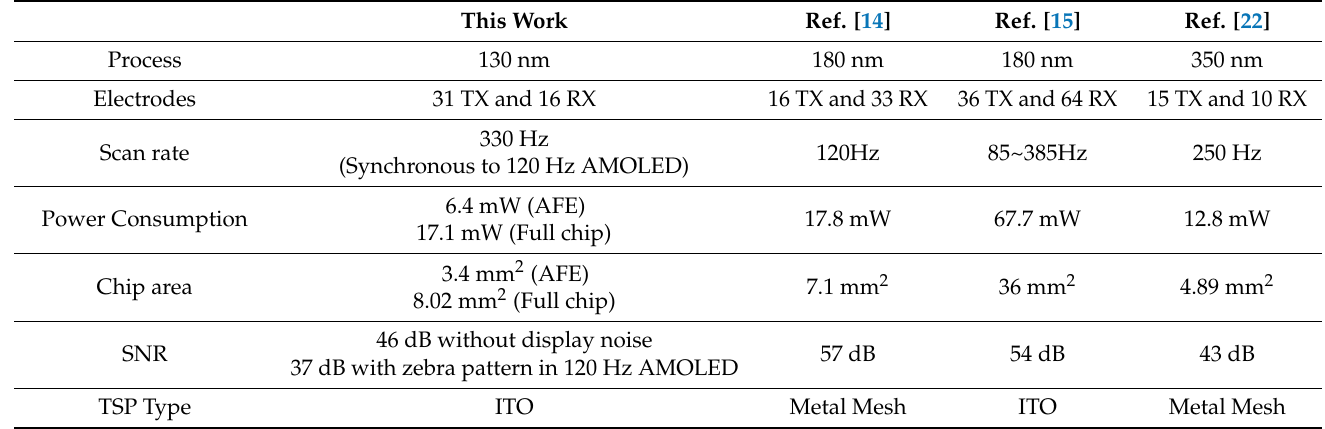
Figure 12. ( a ) Comparison of SNR for reference capacitance (C REF ) during T VP and T HP , and the measured RMS touch profile of ( b ) the proposed differential TSP sensing and ( c ) conventional single-ended sensing. Table 1. Performance summary and comparison to previous